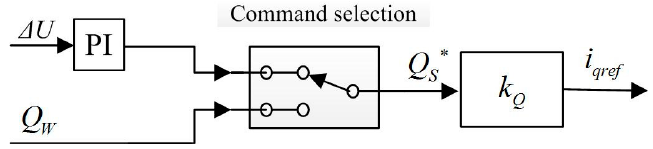
Figure 12. Generation of the reference reactive current.